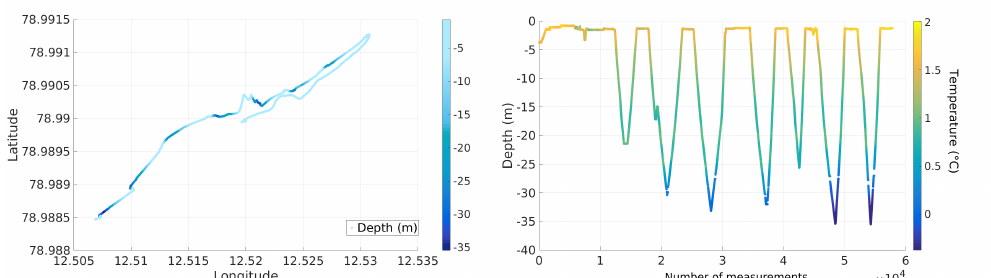
Figure 27. Conwaybreen data from the CTD moved by the winch.